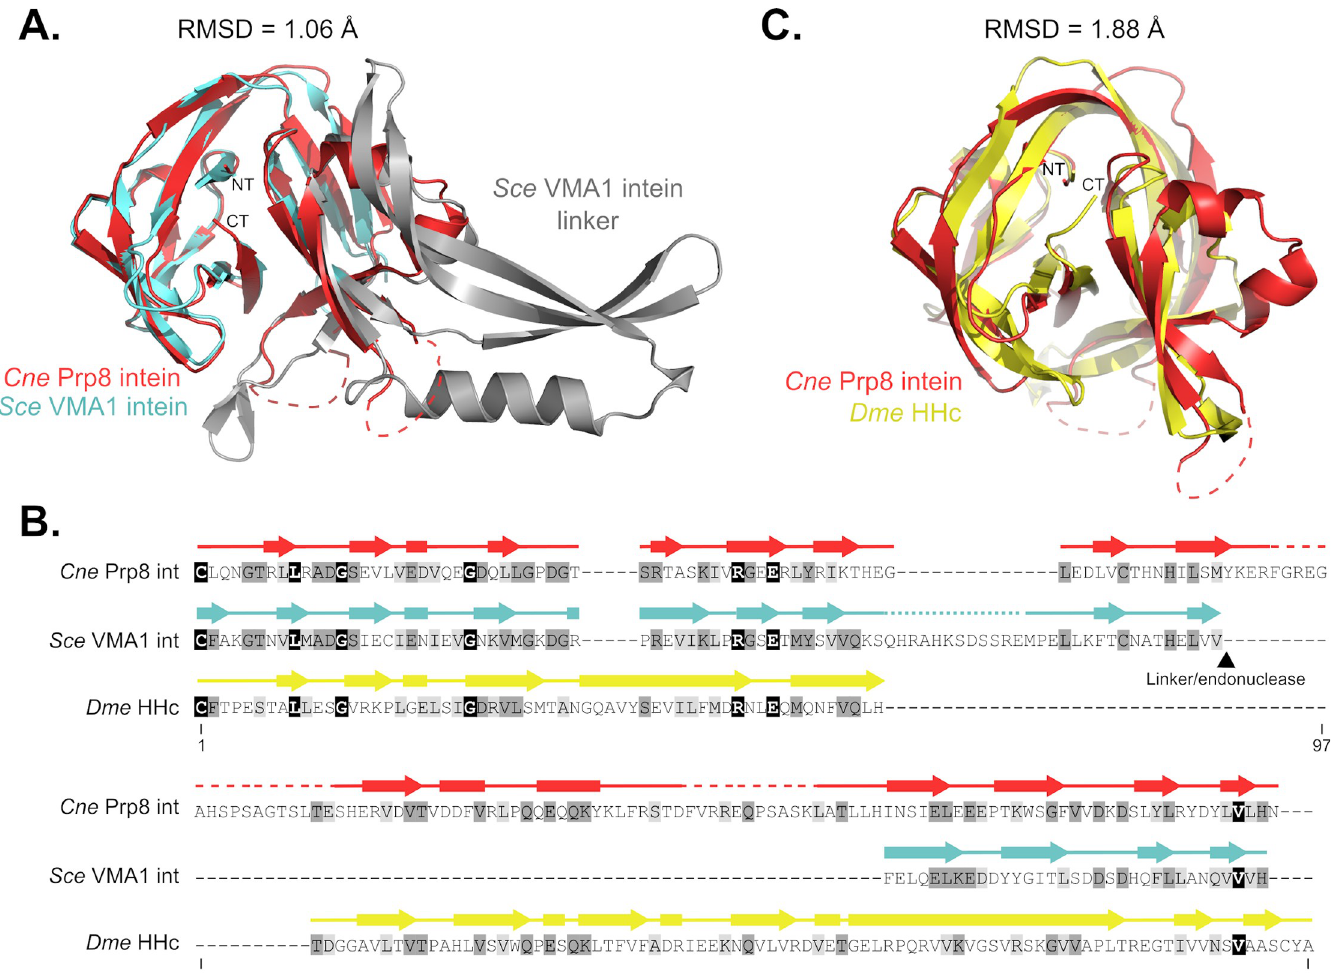
Fig 3. Similarity of the Cne Prp8 intein to eukaryotic protein splicing elements. (A) Overlay of the Cne Prp8 intein (red) with the Sce Vma1 intein (cyan and gray, PDB 1GPP) with an RMSD of 1.06 Å . Structural similarities are most pronounced in the splicing domain (Blocks A, B, F, and G, cyan) of the Sce Vma1 intein, whereas the linker/endonuclease domain (gray) is where the Cne Prp8 intein did not resolve (dashed lines). The NT and CT are annotated. (B) Multiple sequence alignment of Cne Prp8 intein, Sce Vma1 intein, and Dme HHc. Sequence comparison (residues 1–193) reveals significant differences across the 3 proteins, which are only 22.6% identical. Overlaying secondary structure shows that, despite sequence divergence, the proteins have high structural similarity. Shading is as follows: black, identical amino acid; dark gray, conserved amino acid; light gray, similar amino acid substitution. Arrows represent β -strands, rectangles are α -helices. Unresolved regions shown as dashed lines. (C) Overlay of the Cne Prp8 intein (red) with Dme HHc (yellow, PDB 1AT0). Structural 3D BLAST shows parallels between the eukaryotic intein and the eukaryotic protein splicing Hedgehog domain, with an RMSD of 1.88 Å . The NT and CT are annotated. Cne , C . neoformans ; CT, carboxy terminus; Dme , Drosophila melanogaster ; HHc, Hedgehog C-terminal domain; NT, amino terminus; PDB, Protein Data Bank; Prp8, pre-mRNA processing factor 8; RMSD, Root- mean-square deviation; Sce , Saccharomyces cerevisiae .